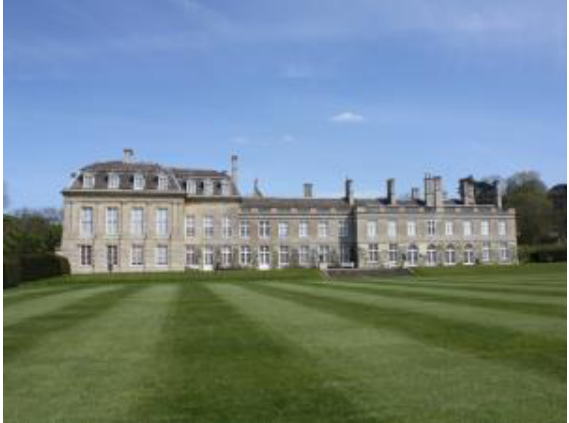
Figure 1 Boughton House. West Elevation  Author